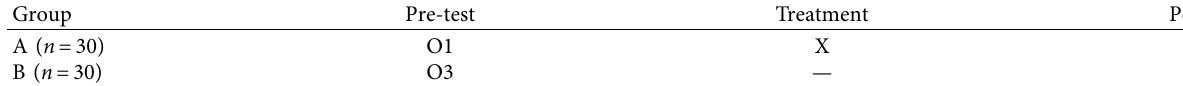
Table 1: Equivalent pre-test and post-test control group design.